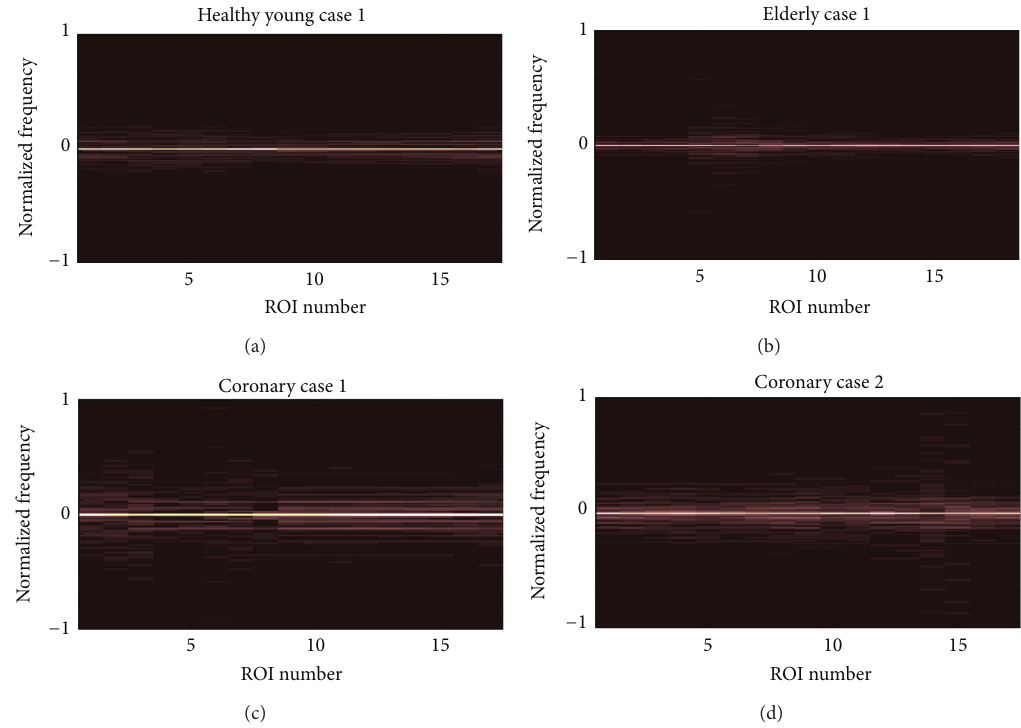
Figure 14: Spatiospectral 2D maps generated when applying the Fourier transform to each column (which corresponds to one ROI) of the spatiotemporal 2D maps shown in Figures 7, 9, 11, and